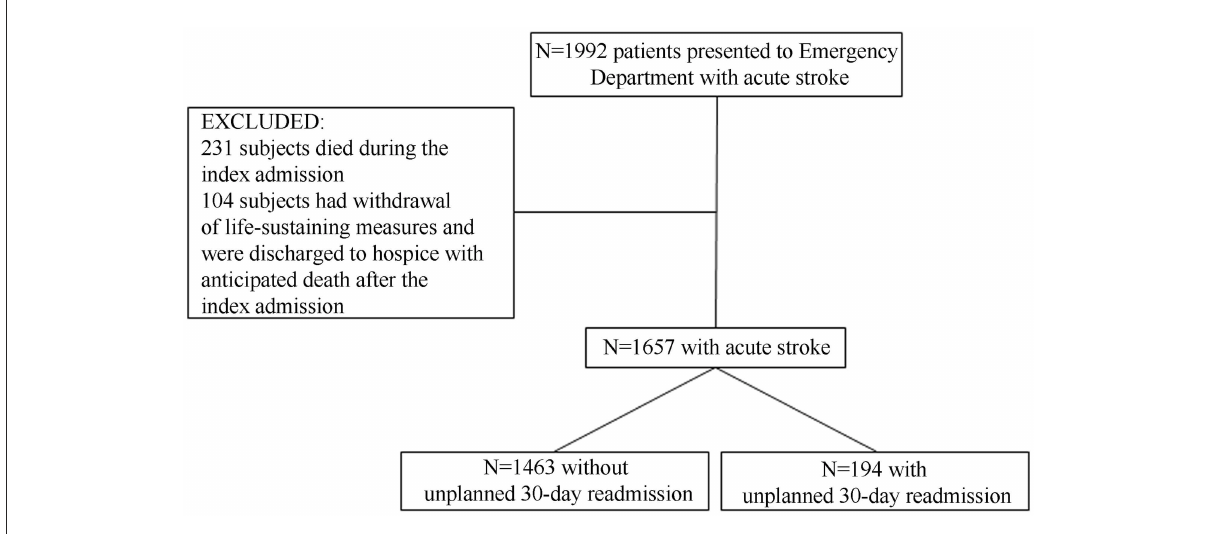
FIGURE1 Patient flow